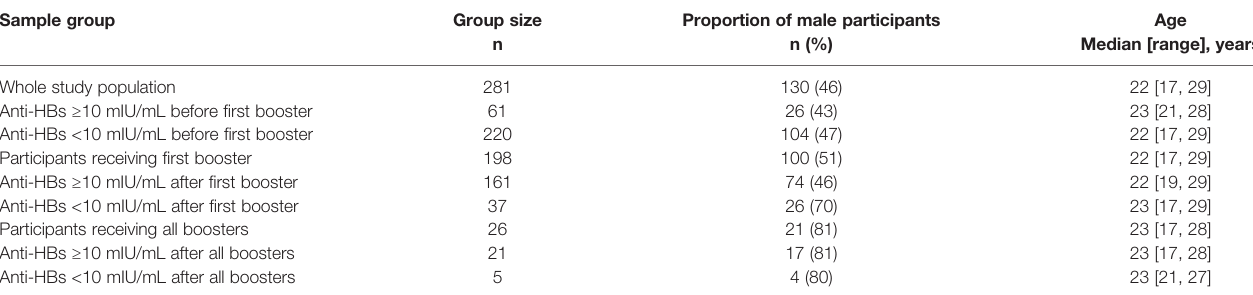
TABLE 1 | Study population